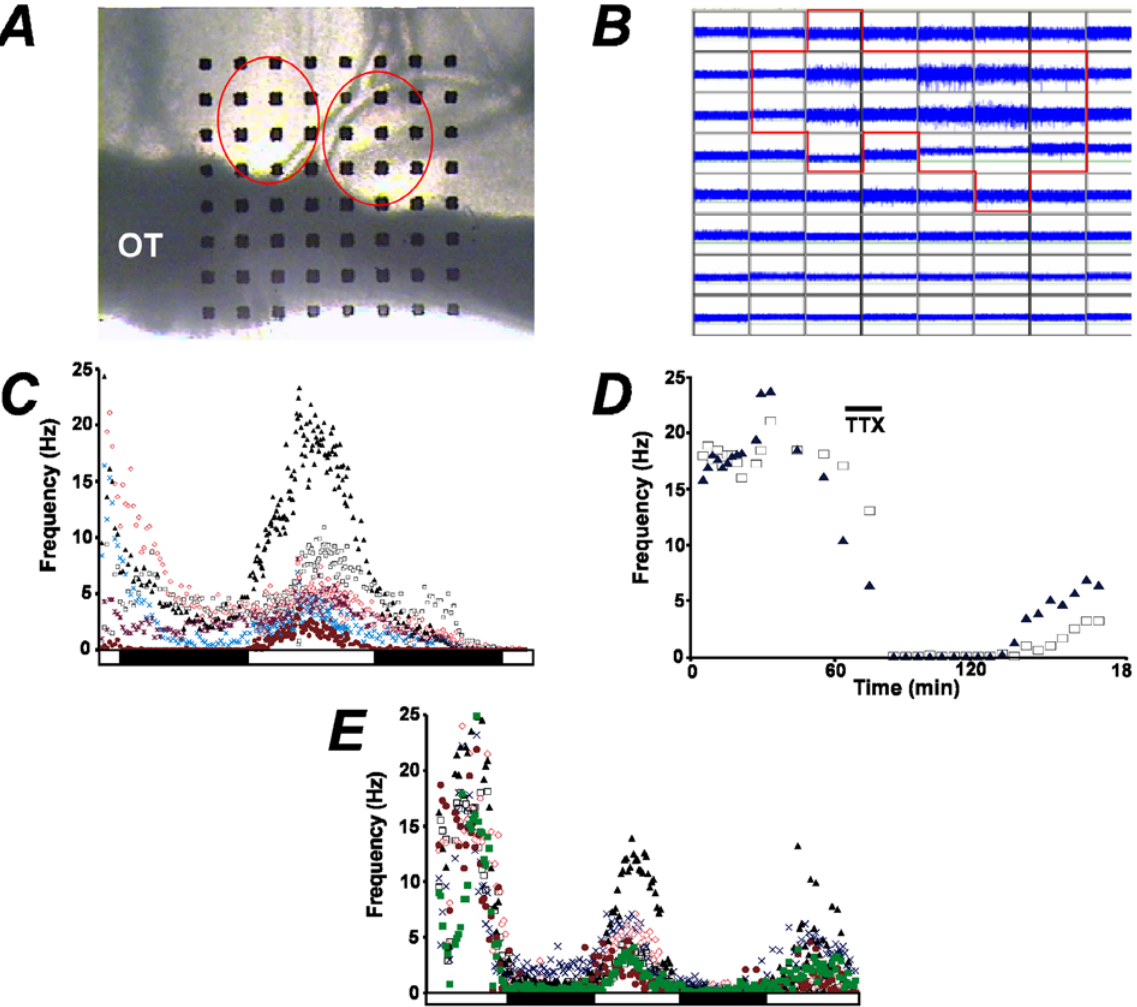
Figure 1. Multi-electrode array recordings of SFR rhythms from SCN. A, Acute SCN slice (300 m m) on probe. Circles outline SCN. OT=optic tract. Electrode spacing=100 m m. B, Oscilloscope view from slice in ( A ) showing spontaneous activity at each electrode (channel) on the probe. Red outlines channels within the SCN. 1 box=2.5 sec/100 m V. C, Six active channels within the SCN showing a robust circadian regulation of the SFR over 40 hr. Light and dark bars indicate the prior entrainment of the animal before slice harvest. D, Perfusion of 1 m M tetrodotoxin (TTX) blocks spontaneous action potentials (2 channels shown). Washout was started 5 min after TTX addition. E, Synchronized rhythms over 3 circadian SFR peaks.